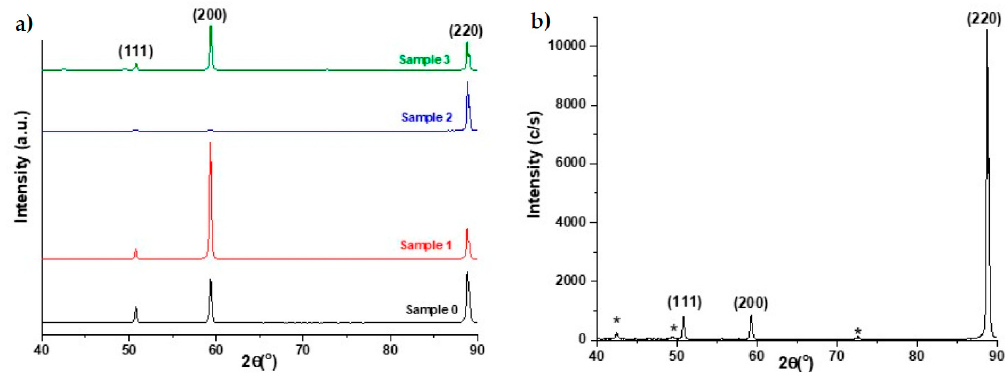
Figure 3. DRX diffractograms of the as-received copper: ( a ) samples 0, 1, 2 and 3; and ( b ) sample 4, with Cu 2 O peaks identified by *. Table 3. Relative intensities of the diffraction planes of the studied copper samples compared with ICDD pattern no. 085-1326.